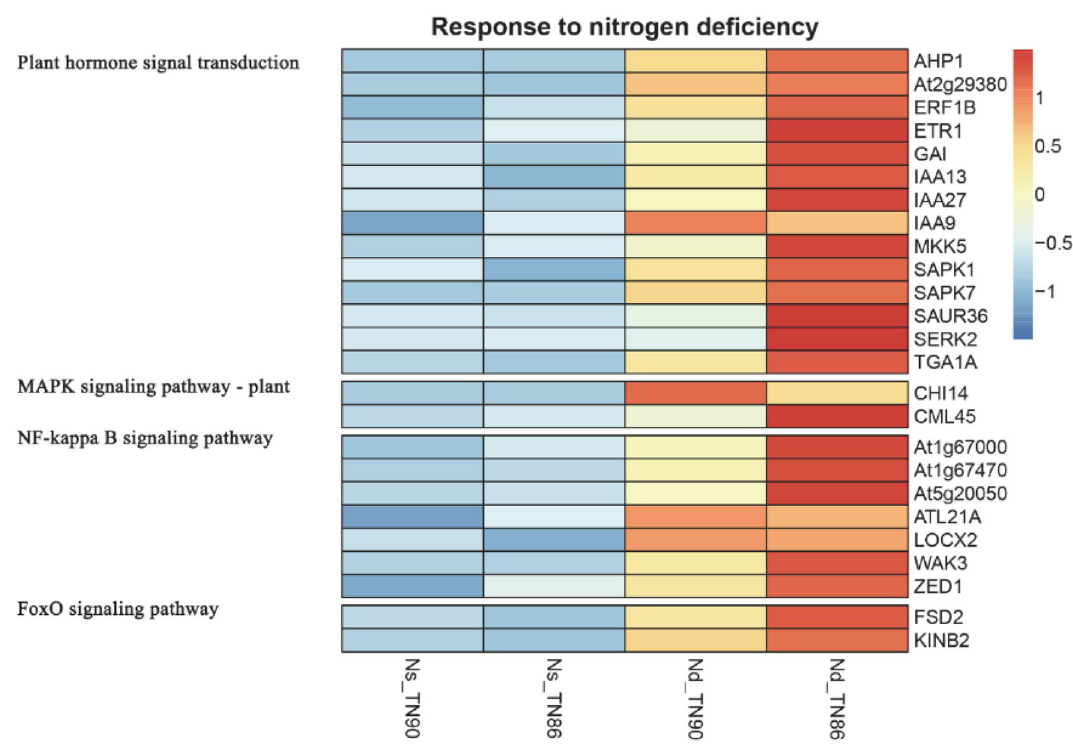
Figure 5. Expression pattern of genes related to nitrogen deficiency responses. Nd-TN90 TN90 cultivated under nitrogen-deficient conditions, Ns-TN90 TN90 cultivated under nitrogen-sufficient conditions, Nd-TN86 TN86 cultivated under nitrogen-deficient conditions, Ns-TN86 TN86 cultivated under nitrogen-sufficient